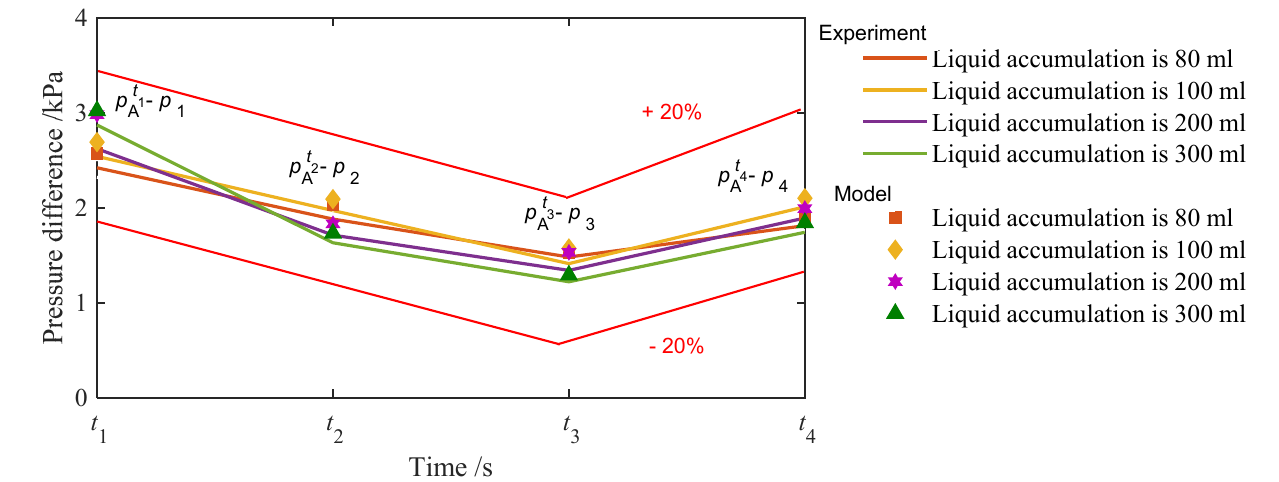
Figure 9. Verification of slug flow pressure model with an inclination of 10°. When the gas velocity is 9.89 m/s, the slug flow image with the liquid accumulation of 300 mL is shown in Figure 10. At t 1 , the liquid at point A gathers to form a liquid bridge, making preparations for the slug head to enter the pipeline, as displayed in Figure 10a. At t 2 , the head of the slug entered the upward inclined pipe, as with the model of t 2 established in Section 3. The liquid film area of the slug is at point A, while the upper liquid slug in the inclined pipe begins to dissipate, as presented in Figure 10b. At t 3 , part of the liquid flows out of the inclined pipe, and the remaining liquid flows back along the pipe, as shown in Figure 10c. The liquid re-aggregates at point A in t 4 , as exhibited in Figure 10d. In addition, due to the direction of the liquid backflow being opposite to the gas in the inclined pipe, a small liquid slug appears in the convective extrusion.